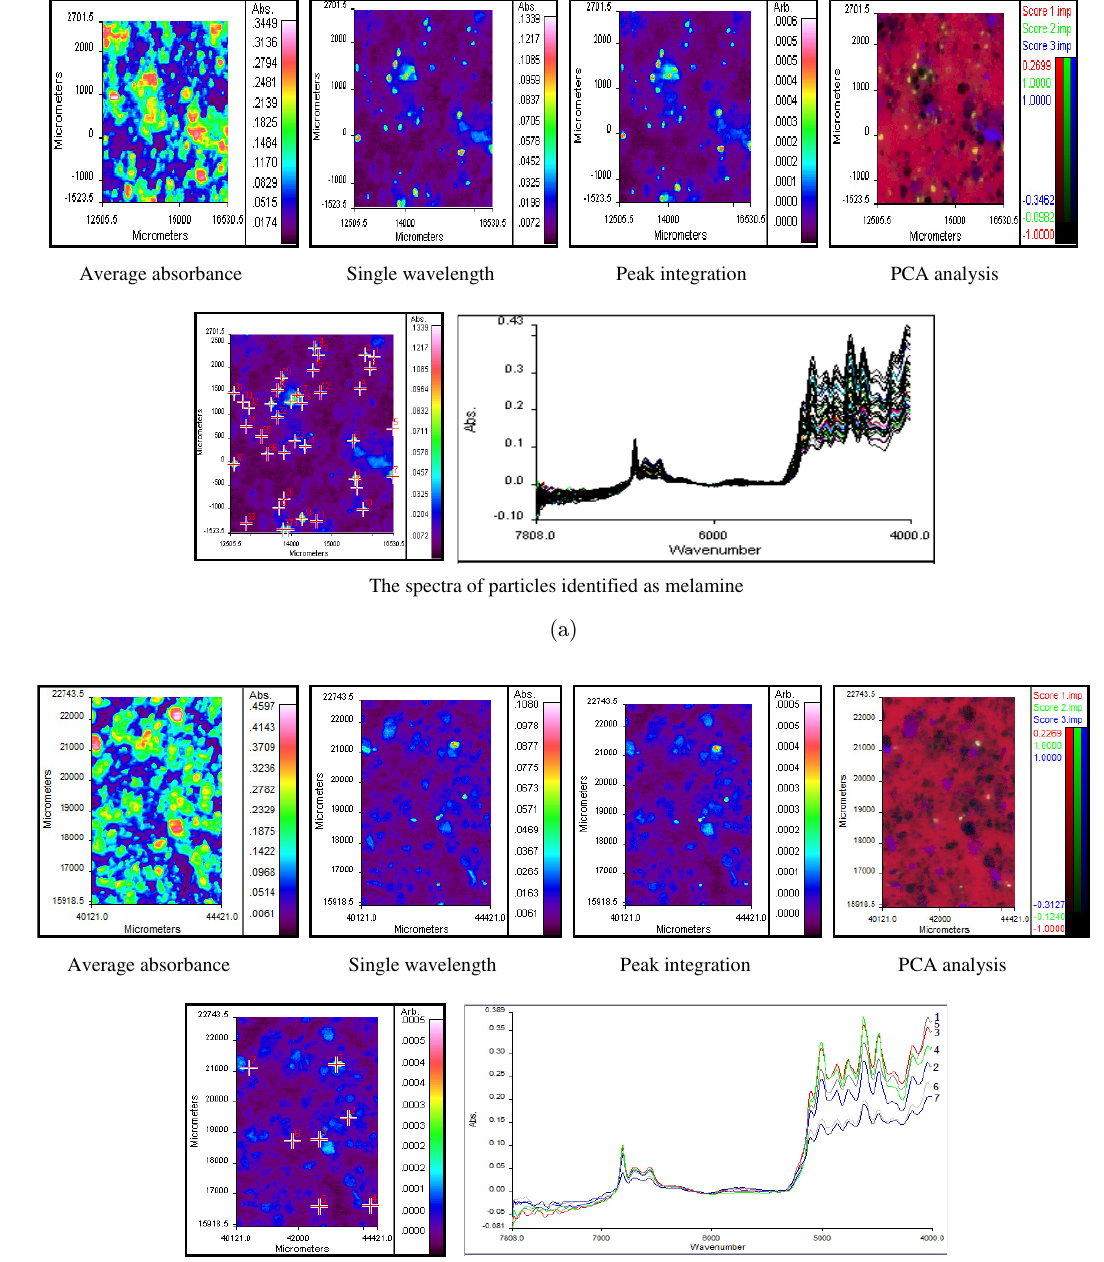
Fig. 7. The results of detecting melamine in samples from set B. (a) Real mixed soybean meal sample with 5% melamine. (b) Real mixed soybean meal sample with 0.5% melamine. (c) Real mixed soybean meal sample with 0.1%